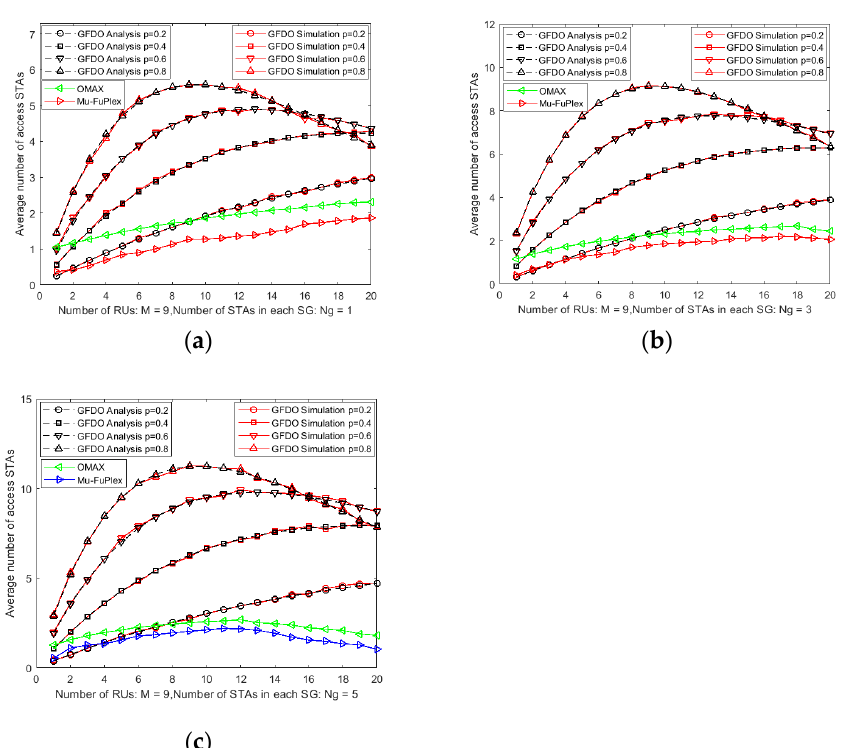
Figure 4. Analysis of the number of access STAs with a different P- probability. ( a ) The average number of access STAs vs. Number of STAs in each SG is 1; ( b ) The average number of access STAs vs. Number of STAs in each SG is 3; ( c ) The average number of access STAs vs. Number of STAs in each SG is 5.